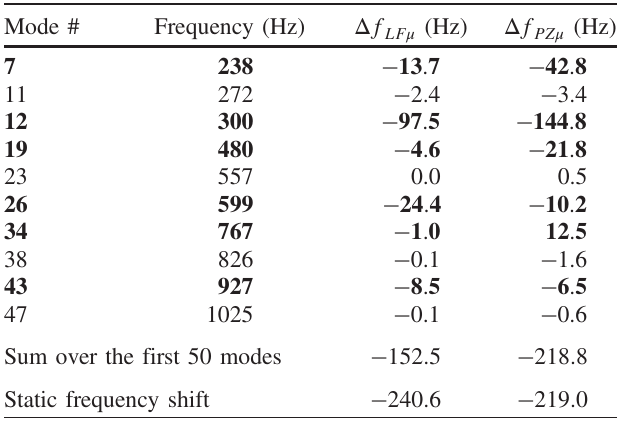
TABLE III. Decomposition of cavity detuning from the static Lorentz force and piezoload. Only the contributing modes are shown, the longitudinal cavity modes are highlighted in